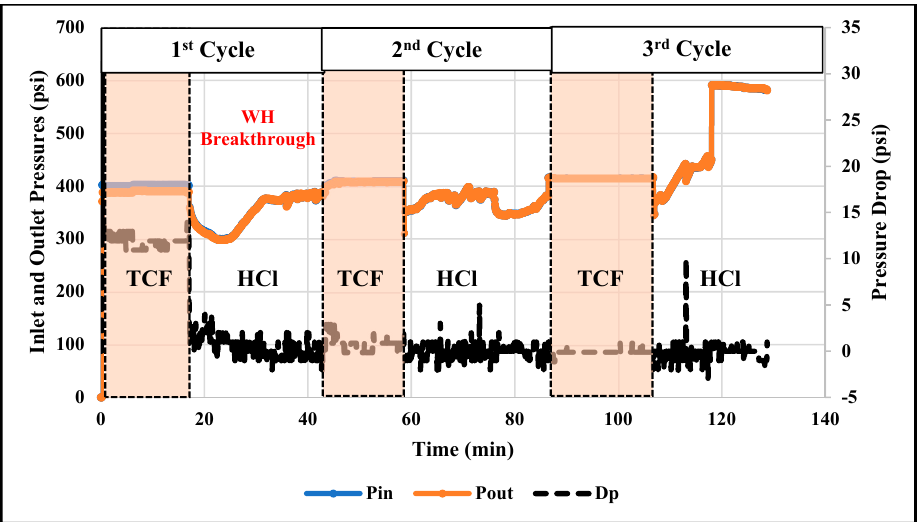
Figure 8. Profiles of inlet (Pin) and outlet (Pout) pressures and the pressure-drop across the high-permeability sample during the thermochemical/HCl treatment.